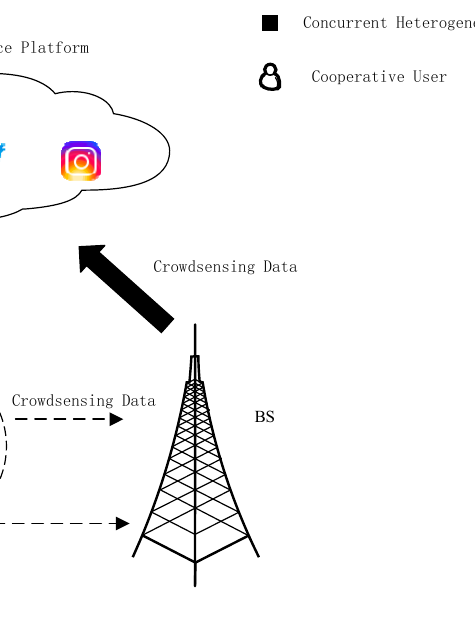
Figure 1. Heterogeneous task assignment model.